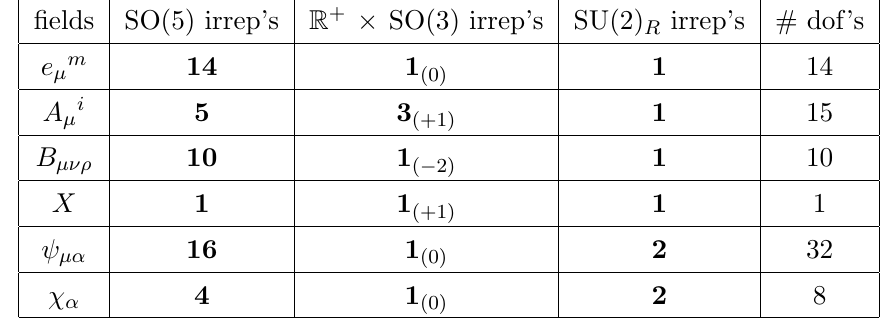
Table 1 . The on-shell (cid:12)eld content of (ungauged) minimal N = 1 supergravity in D = 7. Each (cid:12)eld is massless and hence transforms in some irrep of the corresponding little group SO(5) w.r.t. spacetime di(cid:11)eomorphisms and local Lorentz